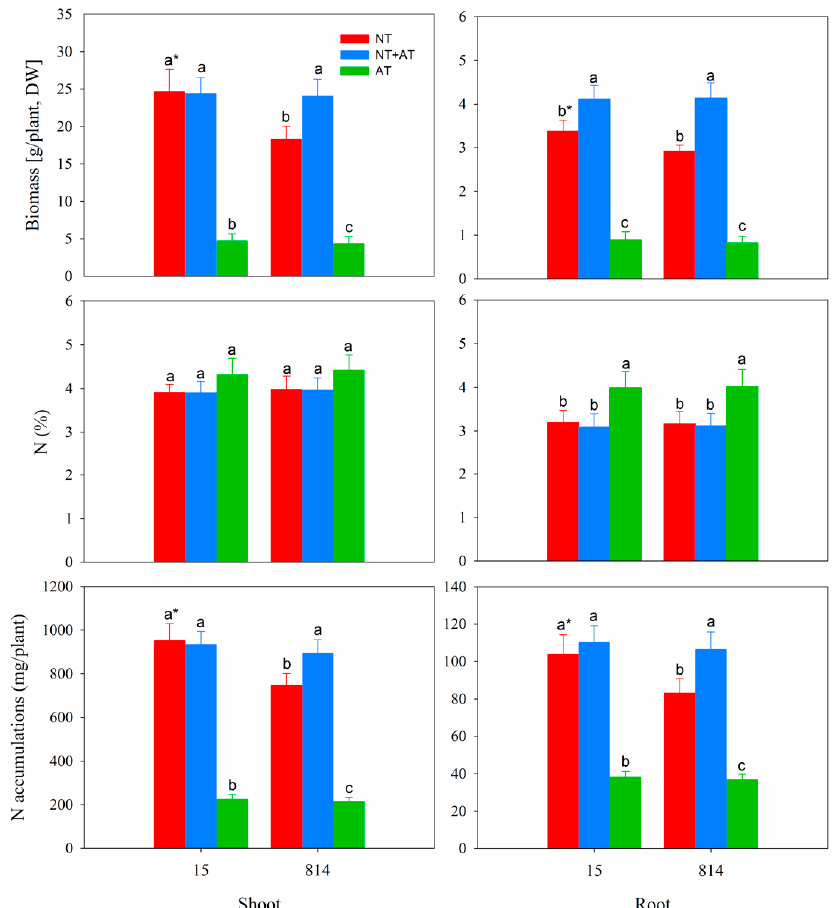
Figure 1. Growth performances of two cultivars, namely, 15 (high N efficiency) and 814 (low N efficiency), after 70 d in different N treatments. The three treatments contained the same amount of N (15 mmol / L). Di ff erent letters at the top of the histogram bars denote significant di ff erences among treatments for the same cultivar ( p < 0.05); asterisks (*) at the top of the histogram bars denote significant di ff erences between cultivars in the same treatment ( p < 0.05); vertical bars indicate the standard deviation (SD) (n =